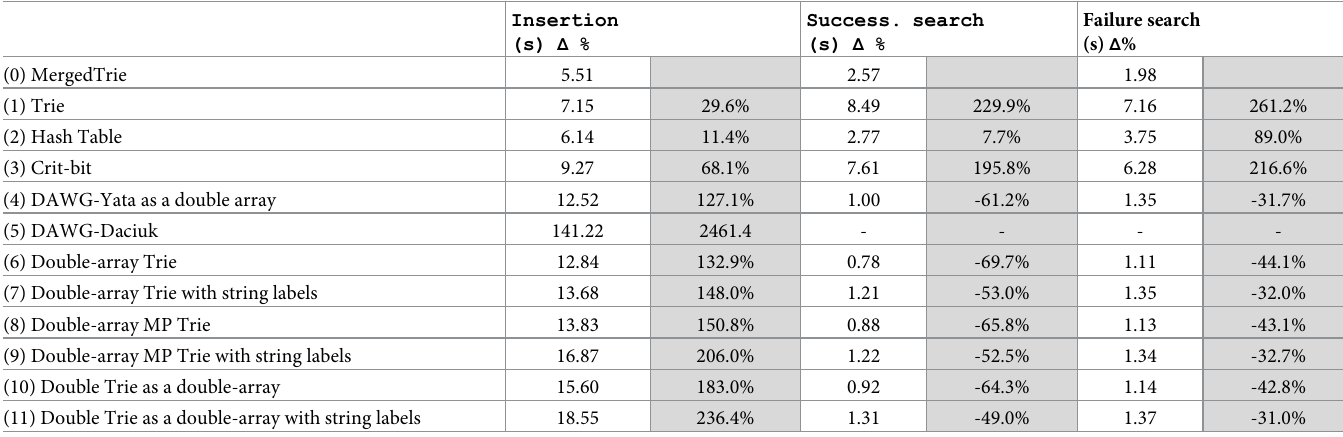
Table 3. Times in seconds in experiment 2 with TREC+ corpora (7,184,348